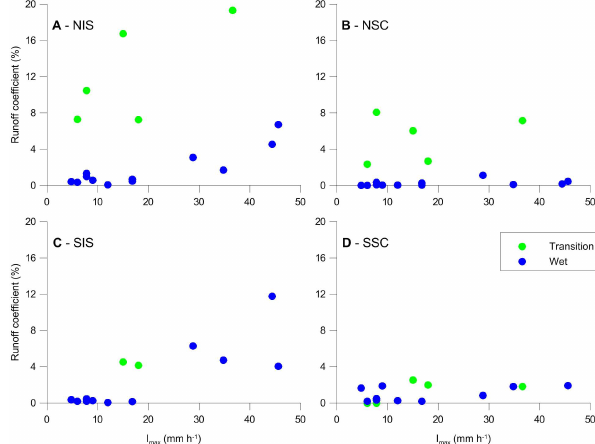
controlling rainfall factor affecting the runoff generation. In